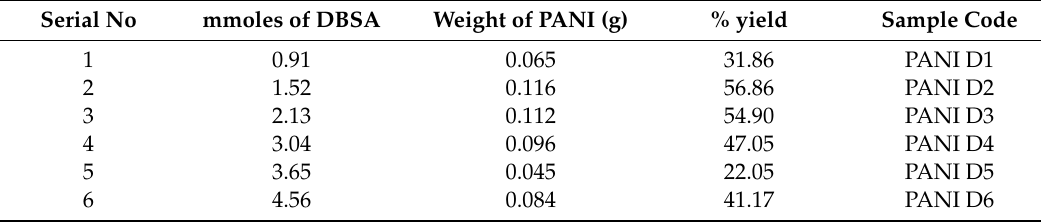
Table 4. E ff ect of amount of dopant (DBSA) on percent yield of PANI. Serial No mmoles of DBSA Weight of PANI (g) % yield Sample